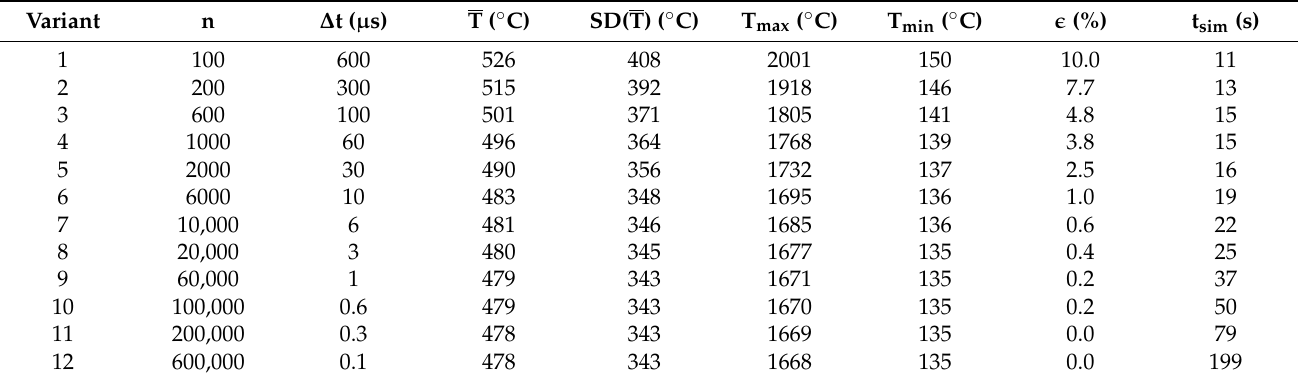
Table 5. Characterization of sheet temperature field depending on (n, ∆ t)-variants (welding time t w = 60